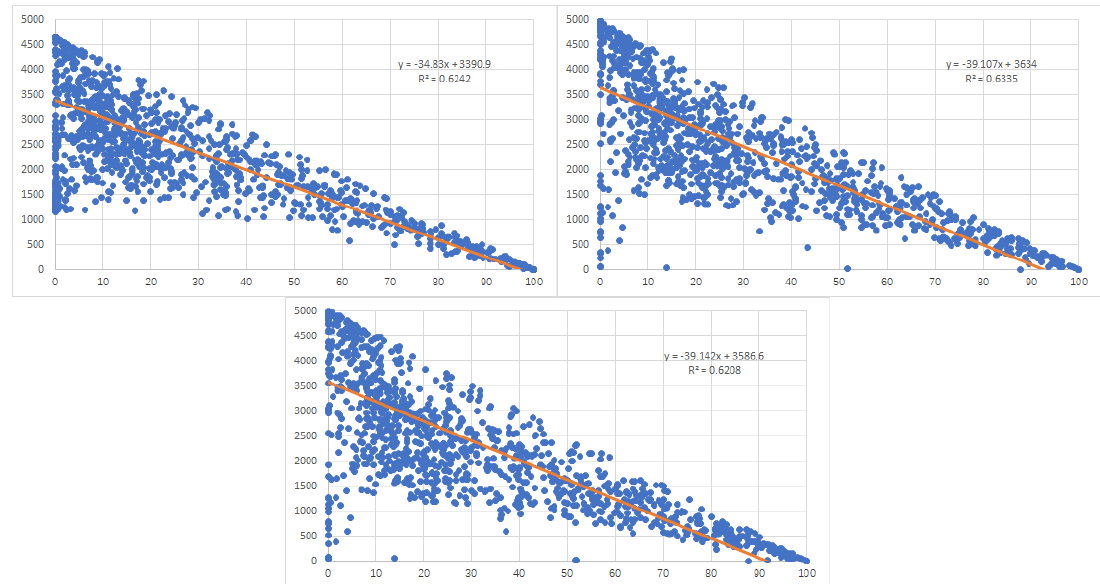
Figure 9. Impact of proportion of built-up area on ESD.4. The Application Practice in the NRIDB. The NRIDB is mainly composed of the Data Center, Computing Center, Service Cen- ter and Visual Web Front-End. It is a server-side + web-side GIS designed for the